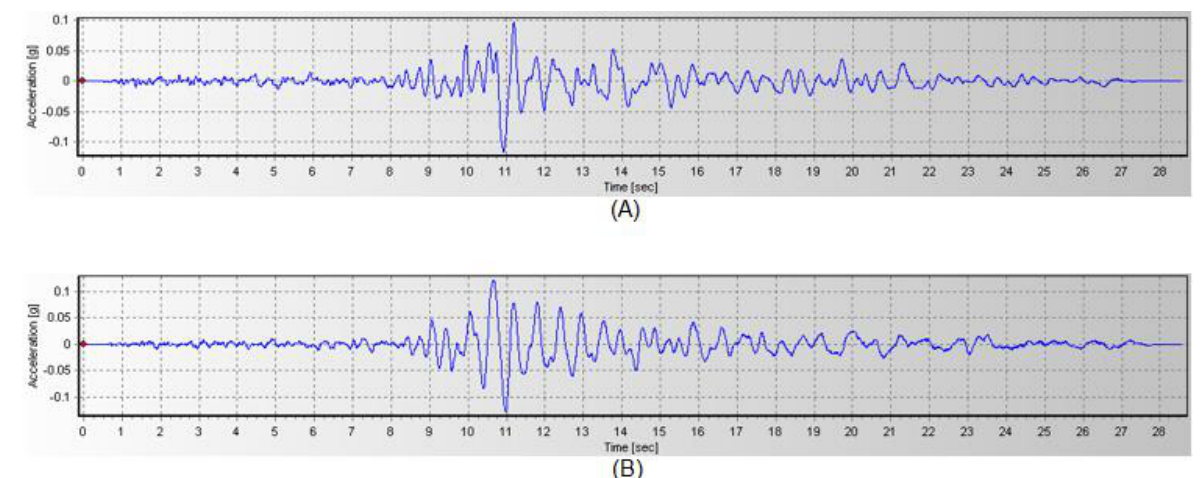
Fig. 10. Couple accelerograms of Imperial valley earthquake (A): X and (B): Y direction.